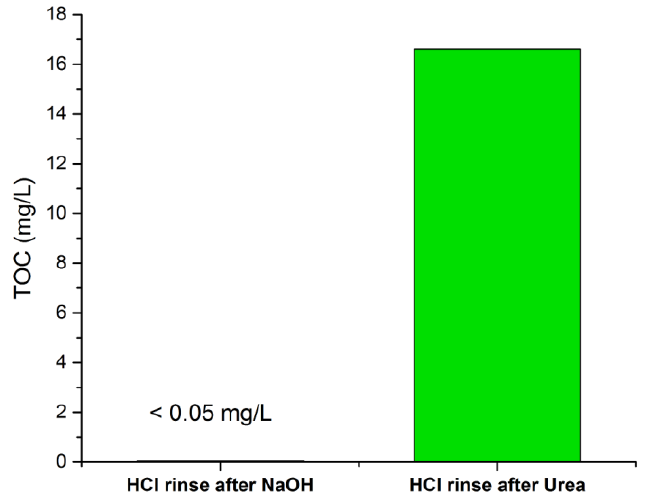
Figure 5. Total organic carbon content (mg/L) in the final stage acid rinse solutions after cleaning the membrane modules with NaOH and urea.